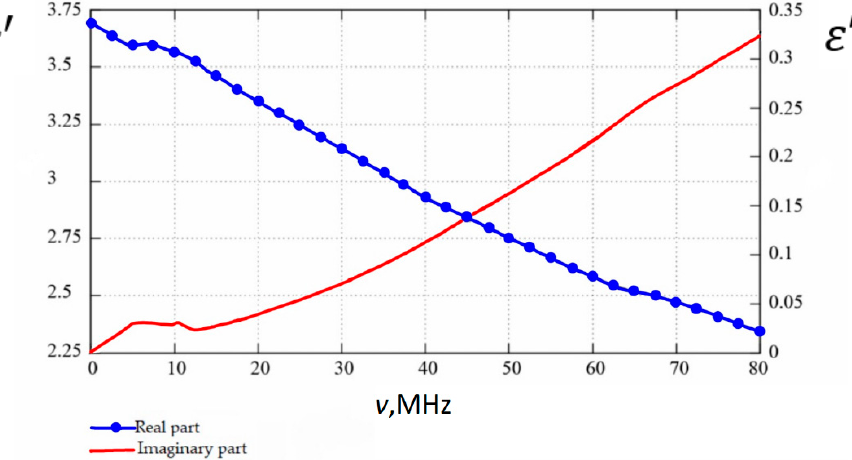
Figure 3. Frequency dependence of the complex dielectric constant of silicon dioxide.